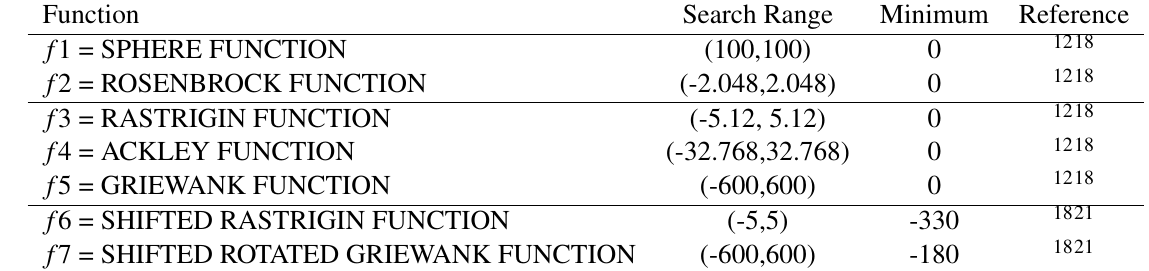
Table 1: Experiment